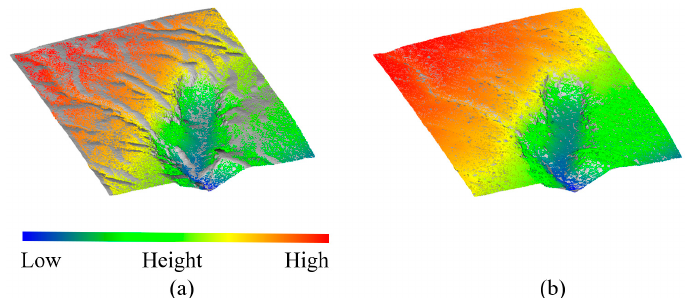
Figure 9. Ground seeds identified by ( a ) the local minimum method and ( b ) the proposed method. Gray surface indicates true terrain.